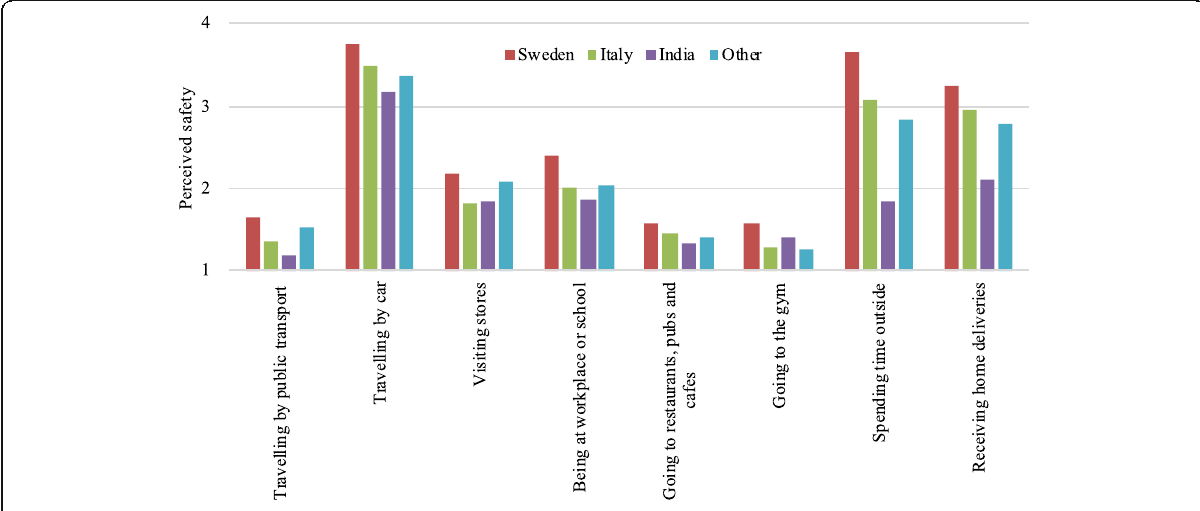
Fig. 5 The respondents ’ average perceived safety while engaging in the different activities from 1 (not safe at all) to 4 (very